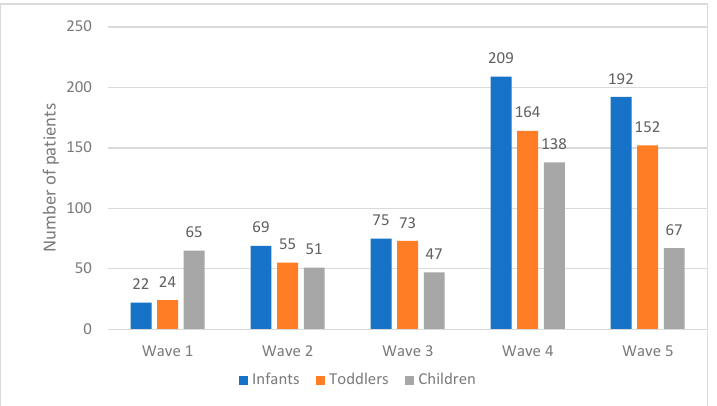
Figure 2. The number of patients in the groups of infants, toddlers, and children in the first five waves of the pandemic.